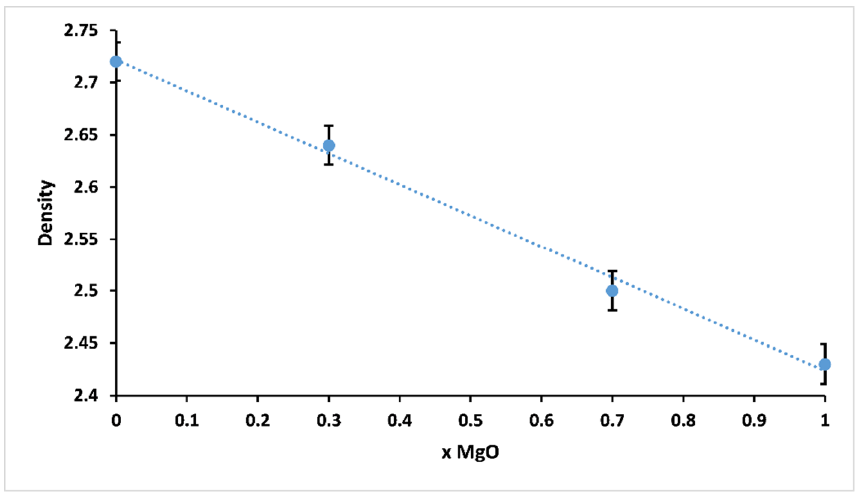
Figure 5. Glass density of 3P 2 O 5 -2K 2 O-(1 − x)CaO-xMgO glasses for 0 ≤ x ≤ 1.